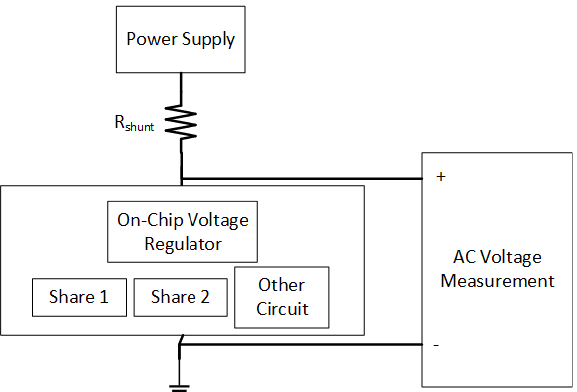
Figure 7. Experimental setup used for the t -test is shown where R shunt is the shunt